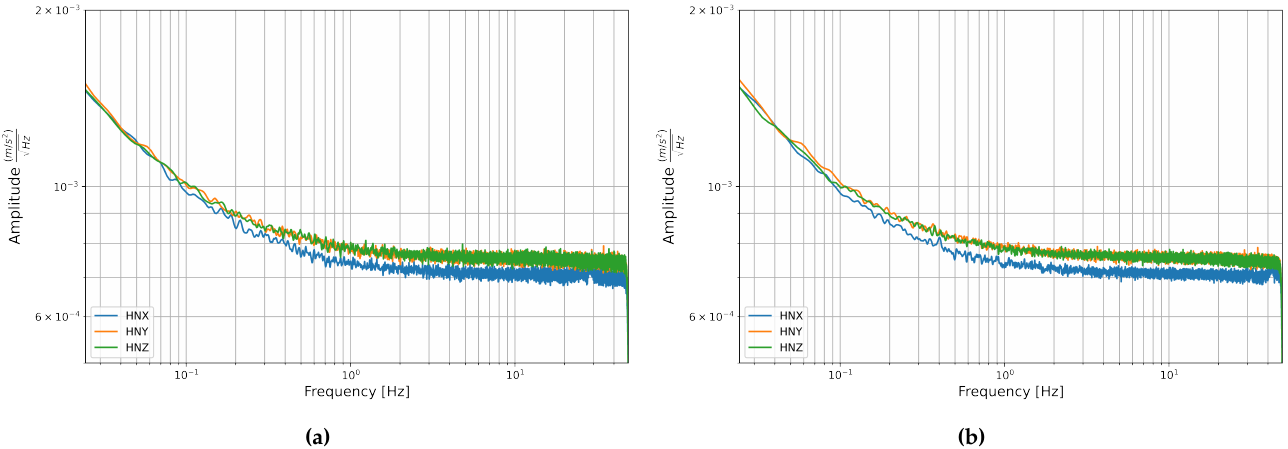
Figure 8. Power Spectral Density of the acceleration components from data recorded in the basement test site of the LMU Geophysical Observatory in Fürstenfeldbruck ( a ) Stream 1: from 27 November to 29 November 2019 and ( b ) Stream 2: from 29 November to 2 December 2019.